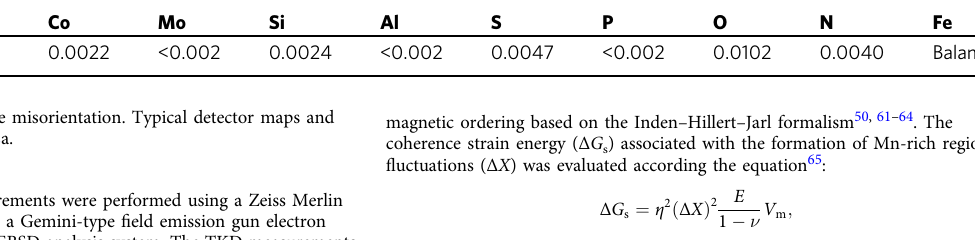
column and Bruker ’ s QUANTAX EBSD analysis system. The TKD measurements were performed at a step size of 2nm and analyzed using the TSL-OIM software. HR-EBSD measurements were performed at a step size of 50 nm using a JEOL JSM-6500F fi eld emission gun scanning electron microscope equipped with a high- speed CCD camera for pattern recording, and analyzed using the TSL-OIM software. Thermodynamics calculations and simulations . The thermodynamics variables (Gibbs free energy and chemical potential of Mn) of the BCC solid solution in function of the Mn content and the phase diagrams were calculated using the Thermocalc software together with the TCFE7 thermodynamic database for iron solid solutions. The Gibbs free energy of the BCC phase is described by a Redlich – Kister – Muggianu excess model plus a function for the contribution from